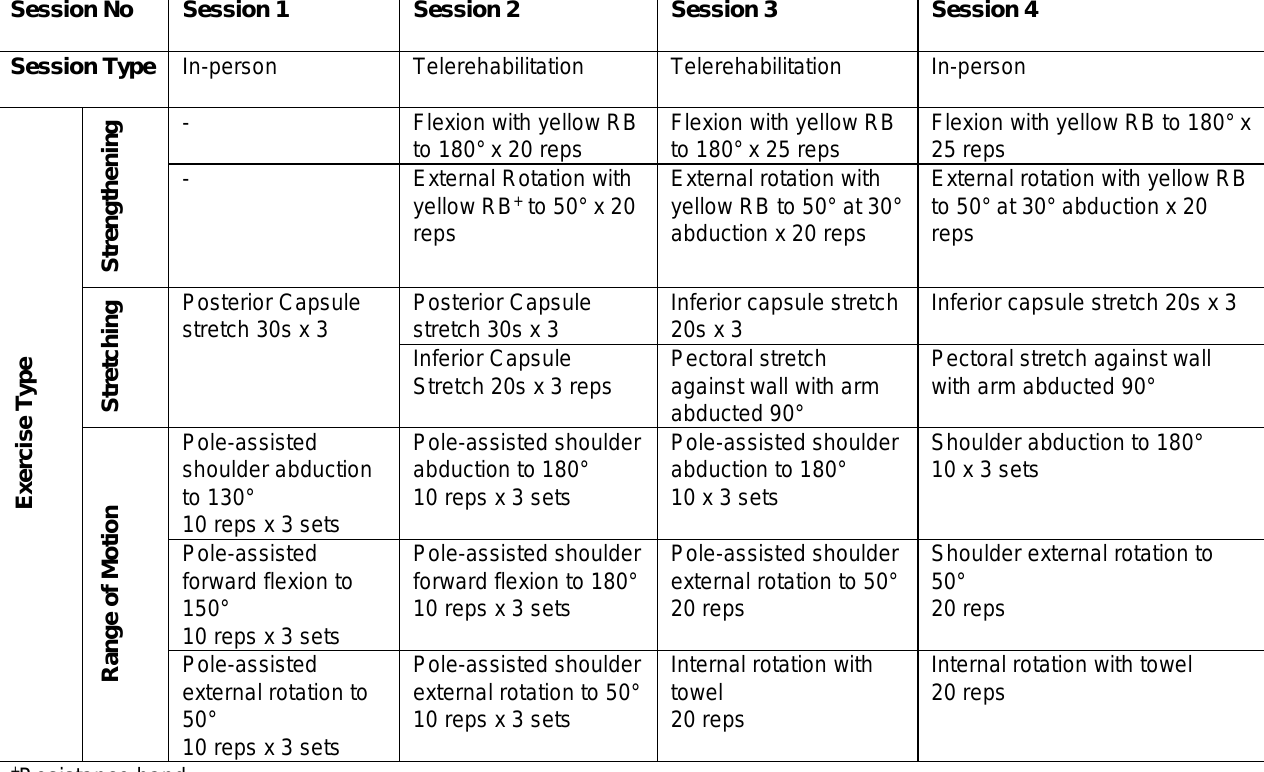
Table 1. Exercise